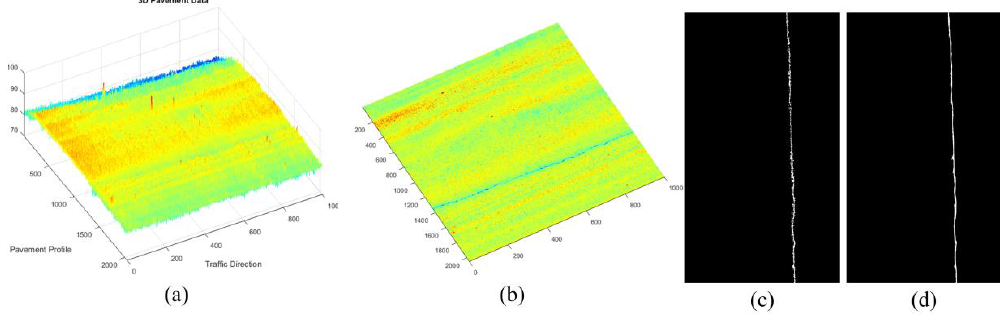
Figure 12. Sparse components and the corresponding pavement longitudinal cracks information, ( a ) 3D pavement data, ( b ) the corresponding sparse components, ( c ) crack information, ( d ) crack ground truth information. Sensors 2018 , 18 , x